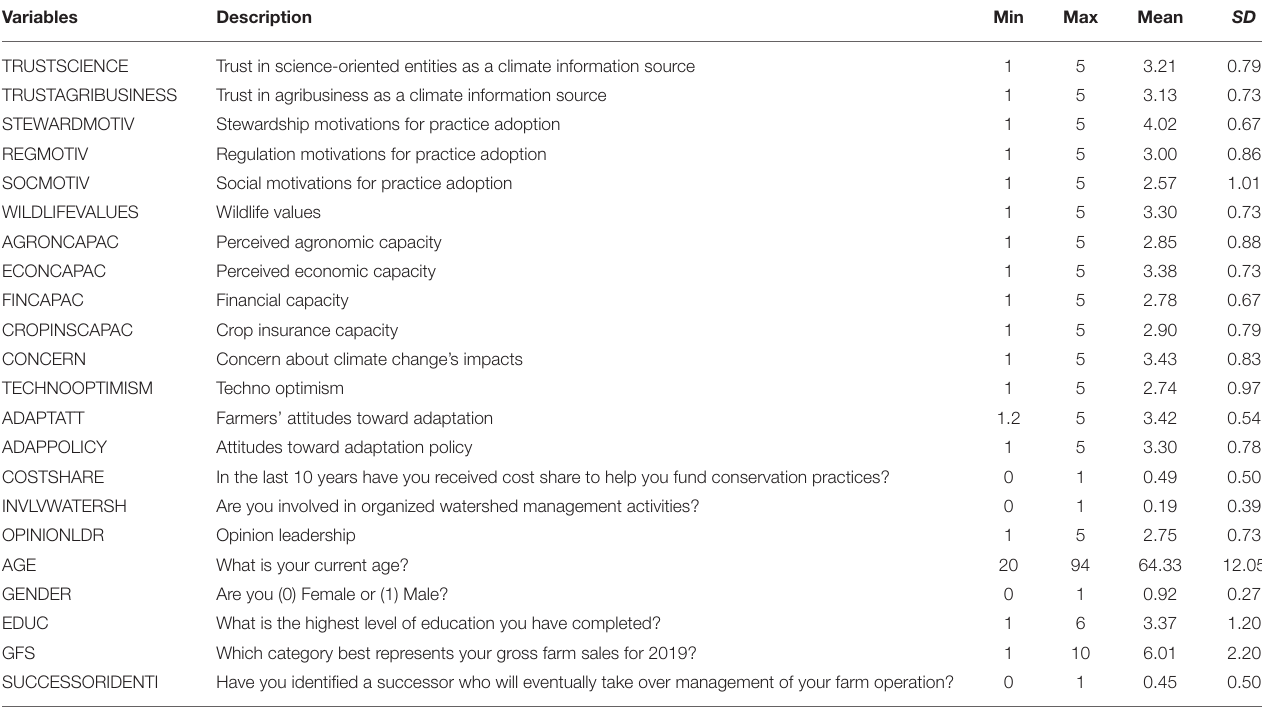
TABLE 1 | Independent variables included in the analysis and their descriptive